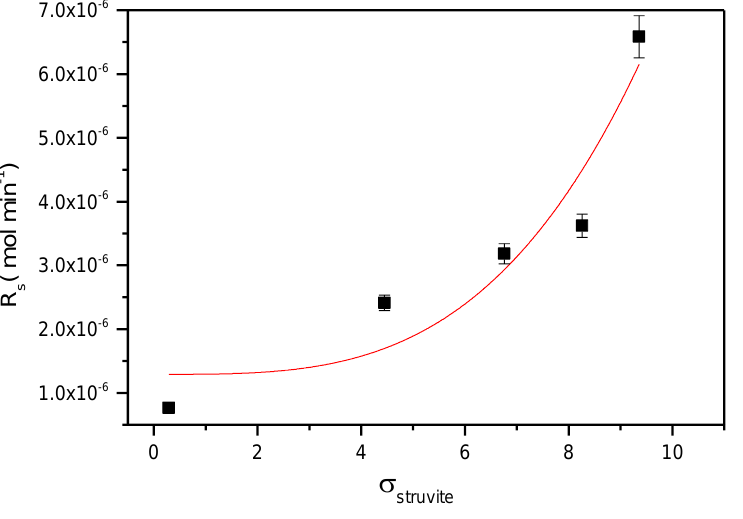
Figure 11. Rate of struvite precipitation in synthetic wastewater as a function of the relative struvite supersaturation. From the plot of the rate of precipitation of struvite as a function of the relative super- saturation with respect to struvite, the apparent order, from Equation (4) was calculated equal to 1.1 ± 0.4, suggesting surface diffusion, a spiral growth mechanism. The appar- ent rate constant was 4.0 × 10 − 7 , which is significantly higher in comparison with the respective constants of the model solutions. The comparison of the rates of precipitation of struvite as a function of the relative supersaturation with respect to struvite, for the different cases studied in this work, is shown in the diagram of Figure